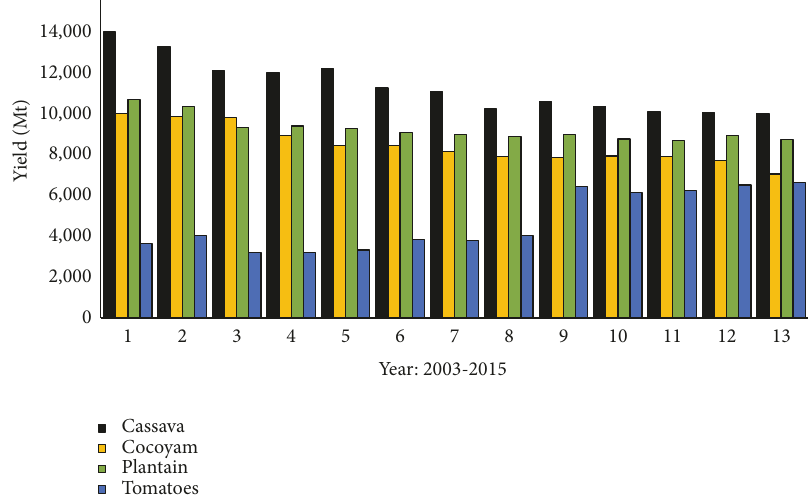
Figure 3: Selected crops yield between 2003 and 2015 within the Fanteakwa District of Ghana. Source: MoFA-Begoro, 2016.